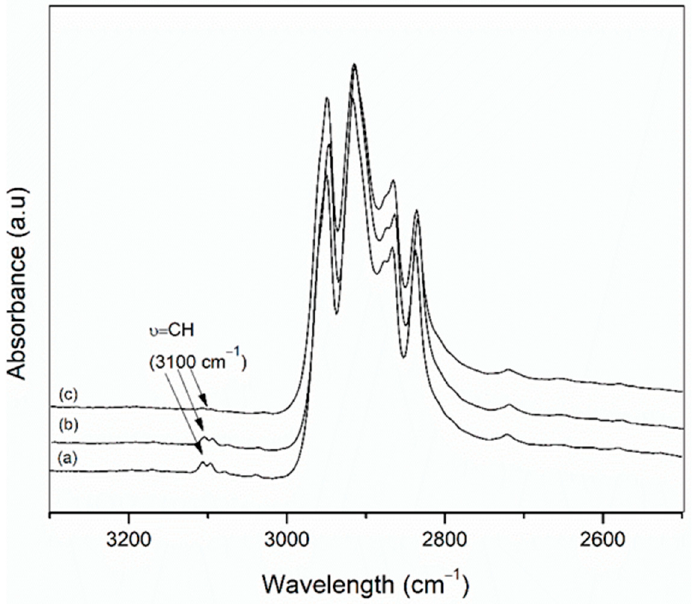
Figure 4. FTIR spectra of FG1 ( a ), FG1A50 ( b ), and FG1A120 ( c ) in the absorption band of 2500–3300 cm − 1 .